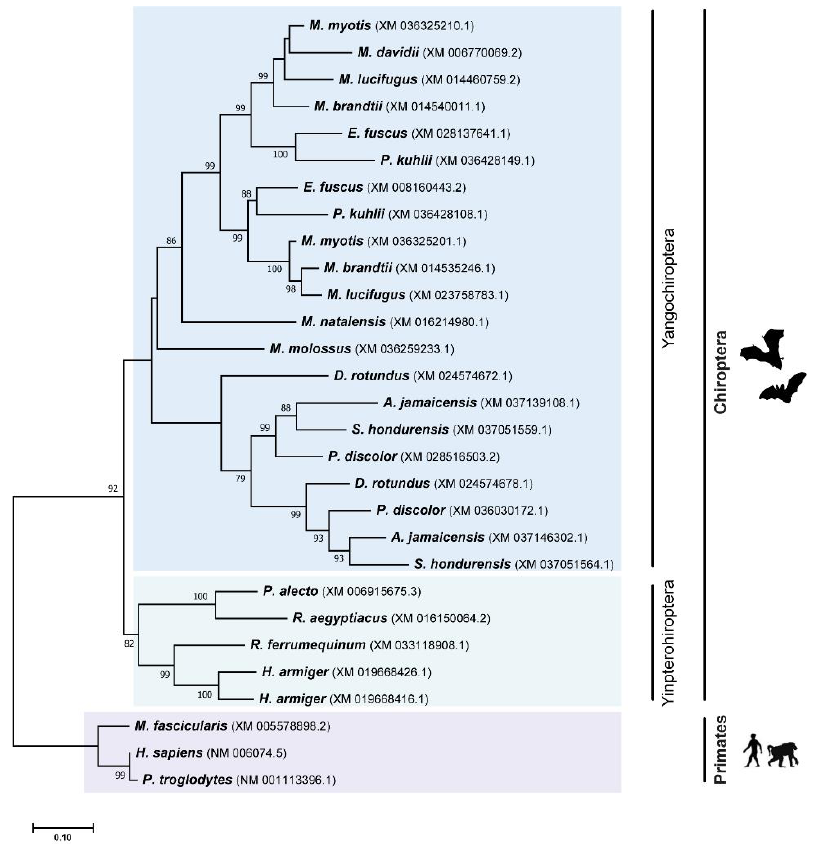
Figure 3. Phylogenetic analysis of TRIM22 protein in different Chiroptera species. The analyses were performed with 1000 generations and 1000 bootstrap searches. Bootstrap values (%) are indicated on the branches, and only bootstraps above 70% are shown.